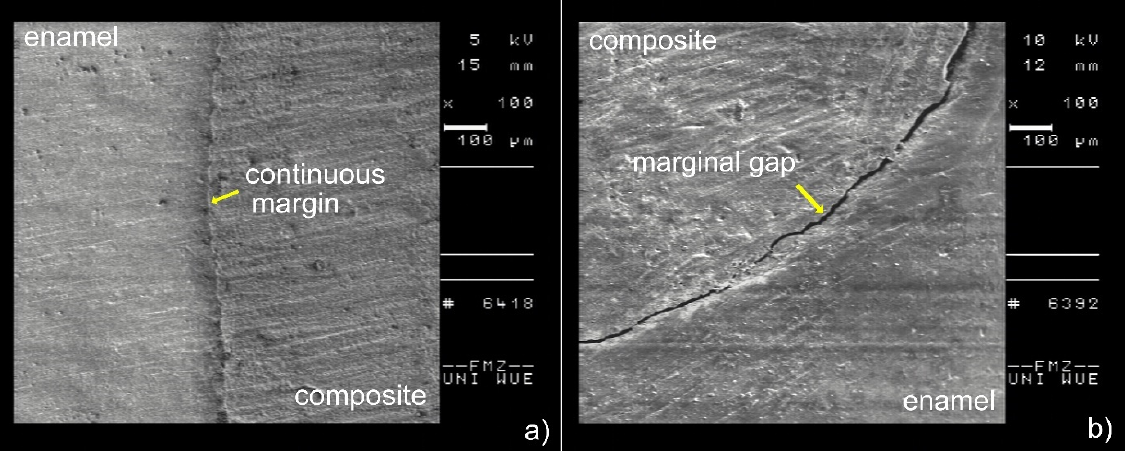
Figure 4. Representative SEM images of the marginal quality outcomes: ( a ) continuous margin and ( b ) marginal gap.